Question: In a single sentence, describe what this figure presents.
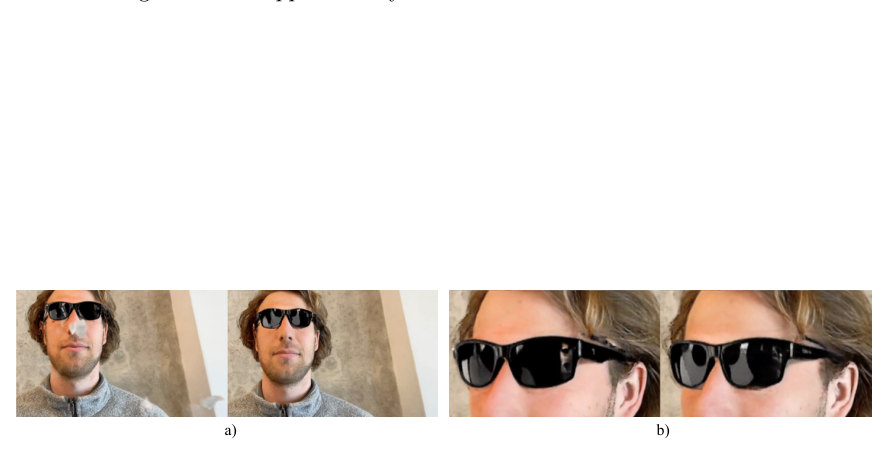
Answer: Results without and with (right) the additional loss term (1). Using the in-mask edit loss term eliminates floaters outside the mask artifacts (a) and increases quality of the inpainting in the mask (b). The artifacts in (b) are hard to appreciate in still images but become much more apparent in the videos provided in the supplementary material.